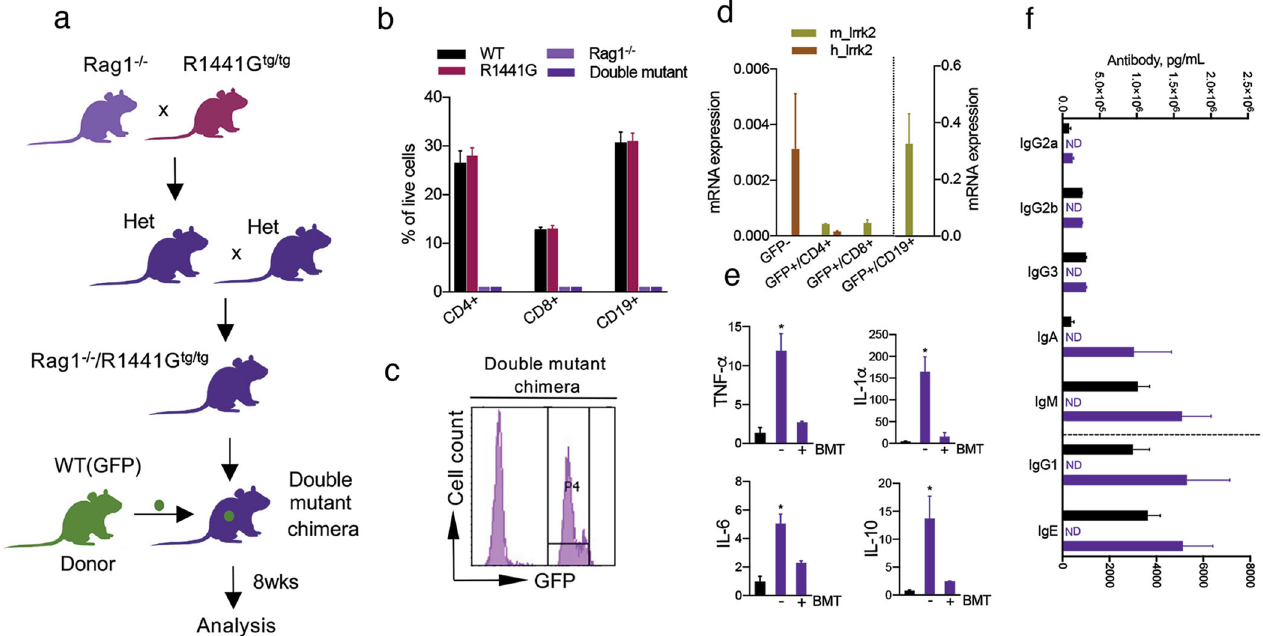
Fig. 1 Breeding paradigm and immune phenotype characterization of double mutant chimeras. a Breeding diagram and BMT strategy used to generate double mutant chimeras, (WT)GFP ->Rag1/R1441G. b Flow cytometry con fi rmed that similar to Rag1 − / − mice, non- transplanted double mutant mice lack both B- and T-lymphocytes regardless of R1441G transgene expression. Note that immune-competent R1441G mice used as a control exhibit normal proportions of adaptive immune cells compared to WT. Data are mean ± SEM, n = 20 for WT and R1441G groups; n = 3 – 4 for Rag1 − / − and double mutant groups. c Representative fl ow cytometry plot from blood of double mutant chimera 8 weeks after BMT demonstrating signi fi cant repopulation with GFP + BM cells. d qPCR analysis showed the lack of human lrrk2 mRNA expression in T- and B-cells sorted from BM-transplanted double mutant chimera ’ s (WT(GFP) -> Rag1/R1441G). Cells were sorted based on GFP + /CD4 + (CD4-PerCP-CY5.5), GFP + /CD8 + (CD8-PE-CY7) and GFP + /CD19 + (CD19-APC-CY7) fl uorescent intensity. Sorted GFP- cells from double mutant chimeras (innate immune cells) were used as a positive control for human lrrk2 mRNA expression. mRNA expression was normalized to mouse β -actin. Data are mean ± SEM, n = 4. e , f Similar to Rag1 chimeras, serum cytokines, and antibodies are back to control R1441G level in BM-transplanted double mutant chimeras. Data are mean ± SEM, n = 5 – 10 for each group. ND not